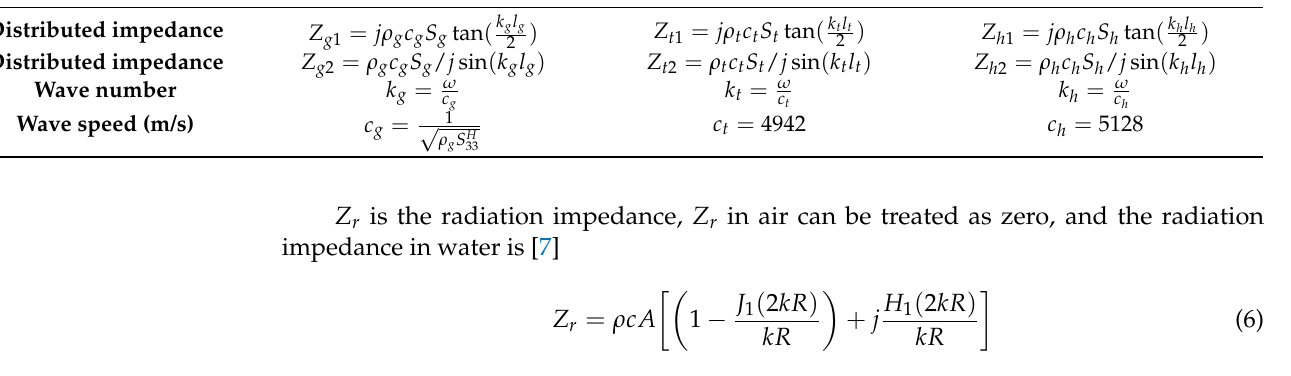
Figure 5. The electromechanical equivalent circuit of the Tonpilz Terfenol-D transducer without material losses. Table 2. PWM equivalent circuit parameters. Terfenol-D Tail Mass Head